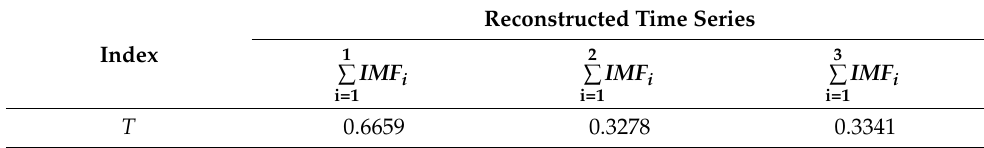
Table 1. Index T value of the different IMFs of BRST station retrieval.